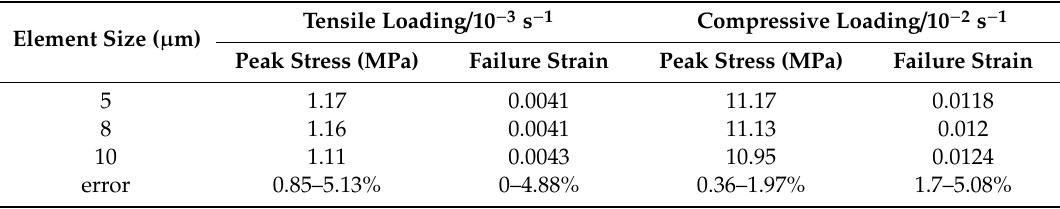
Table 3. Calculated peak stress and failure